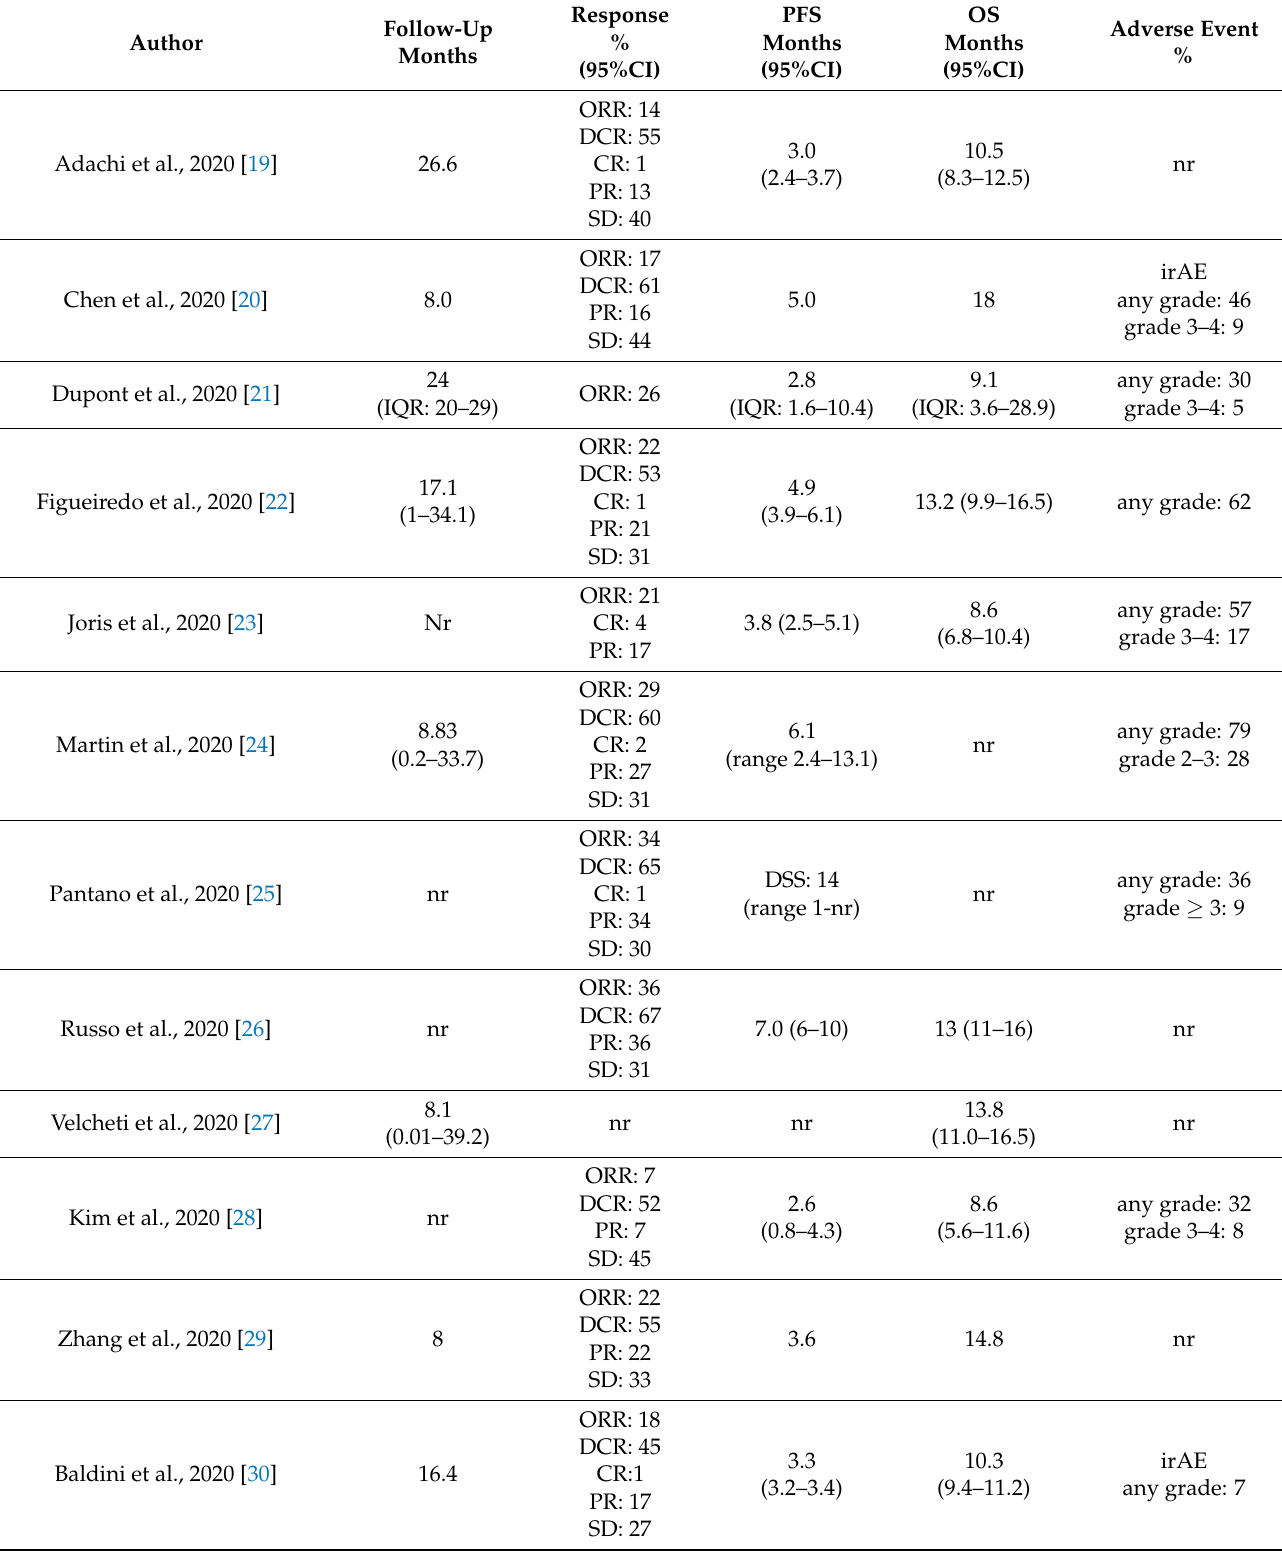
Table 2. Outcome of the real-world studies enrolled in qualitative synthesis and